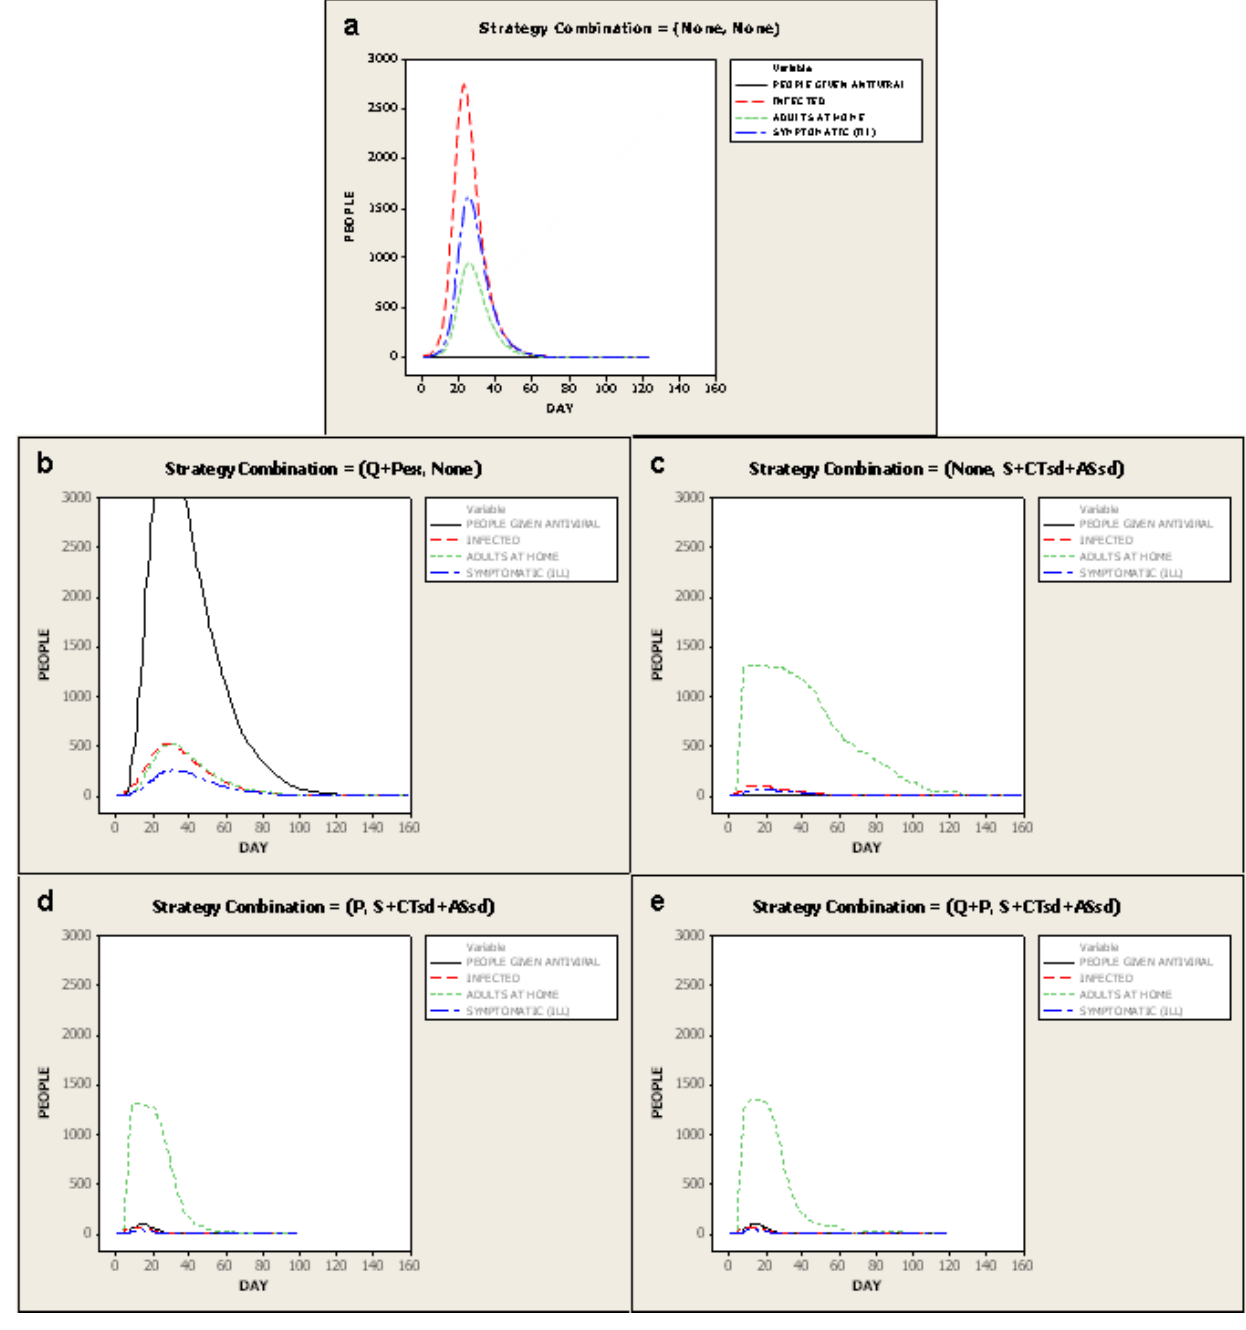
Figure 4. Epidemic effects without and with various mitigation strategies. Plots of numbers of individuals infected, symptomatic, given antivirals, and adult days at home by day of pandemic without mitigation strategies and with mitigation strategies applied for an I F 1.5 (1918-like; Pandemic Severity Index [PSI] 4–5 pandemic); with Ferguson-like disease manifestation and strategies implemented at 90% compliance with regional mitigation. Plots are averages of all 100 simulations done. Comparisons are to the plot with no mitigation strategies applied. a—no mitigation strategies applied. Note the early peak of 1500 symptomatic cases at day 28 and that approximately 900 adults (9% of the population) are at home from illness at peak. Epidemic effects end by day 60. b—all case-based interventions applied (Q + PEx). Note the significant requirements for antiviral drugs ( . 30% of population receives antivirals at peak). Symptomatic cases are contained to , 250 at peak and adult days at home peak at 500 from illness or home quarantine. The epidemic effects last for 160 days. c—all network-based interventions applied (S + CTsd + ASsd). Note the significant, sustained increase in adult days at home because of the school closings and childcare required, peaking at approximately 1400 adults home/day and tapering off slowly. However, symptomatic cases are contained to , 200 at peak. The epidemic effects last approximately 120 days. d—the best strategy we found in these simulations (P + S + CTsd + ASsd). Ill persons are treated with antivirals, household members of ill persons receive antiviral prophylaxis, schools are closed and children’s and teenagers’ contacts are reduced by 90%, adults’ and seniors’ non-work contacts are decreased by 90% and workplace contacts by 50%. Note the similar peak of adult days at home (at around 1400) as when only network-based strategies are applied, but with rapid fall-off, with nearly no adult days at home required after approximately day 50. Symptomatic cases are minimized to , 200 at peak. Epidemic effects end around day 100. e—the best strategy (P + S + CTsd + ASsd) with Q added. Note that the addition of Q does not change the number of symptomatic cases, but does extend required adult days at home and lengthens the epidemic effects to approximately 120 days.